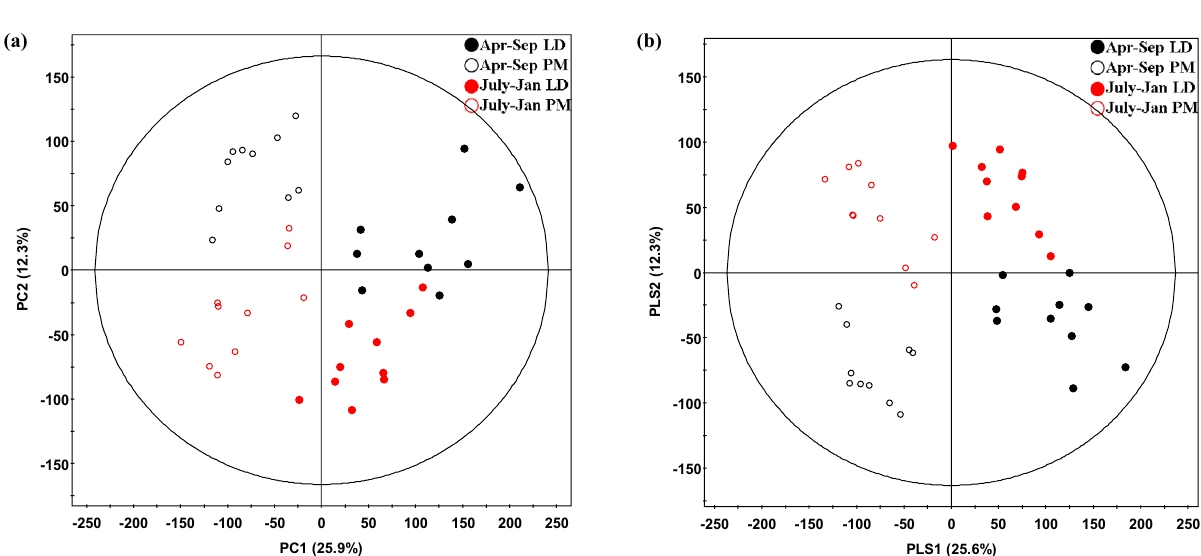
Figure 4. PCA and PLS-DA score plots of metabolome profiling porcine LD ( longissimus dorsi ) and PM ( psoas major ) muscles from two production replicates. The plots were generated using the SIMCAP-P + software (version 12.0, Umetrics, Umea, Sweden); (a) PCA score plot, R 2 X = 0.49, Q 2 = 0.336; (b) PLS-DA score plot, R 2 X = 0.559, R 2 Y = 0.981, Q 2 = 0.835, P < 0.05. July–Jan: Pigs weaned in July 2016 and harvested in January